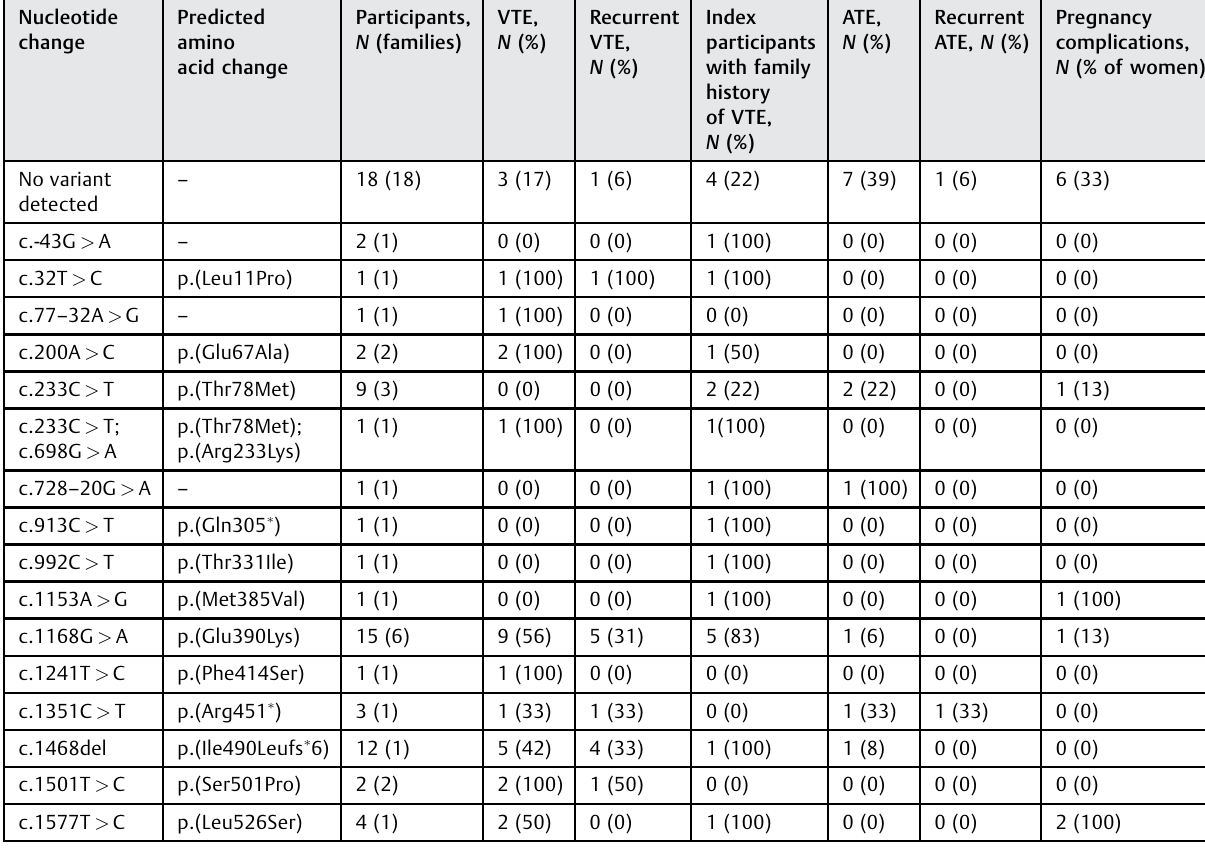
Table 3 Clinical characteristics of 75 study participants (43 index participants and 32 family members) Nucleotide